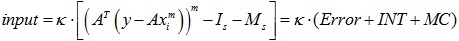
Evolution of approximation for purple-highlighted elements in Fig. 2B, using DG-IST with d = opt = 171 (left panel) and IST (right panel).First row of each panel shows the evolution of the two elements, black horizontal lines declare the original elements to be approximated and vertical pink lines (only left panel) show the iterations at which elimination of inhibition takes place for the second largest element in the corresponding column of matrix xm. The second row of each panel illustrates the Input to each GC through the iterative process, input=κ⋅[(AT(y−Axim))m−Is−Ms]=κ⋅(Error+INT+MC). The Error, MC, and INT values that add up to form the Input value are shown in the remaining rows of each panel.